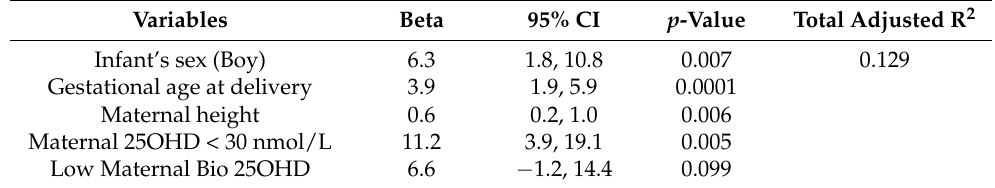
Table 7. The final model of factors associated with crown–heel length at